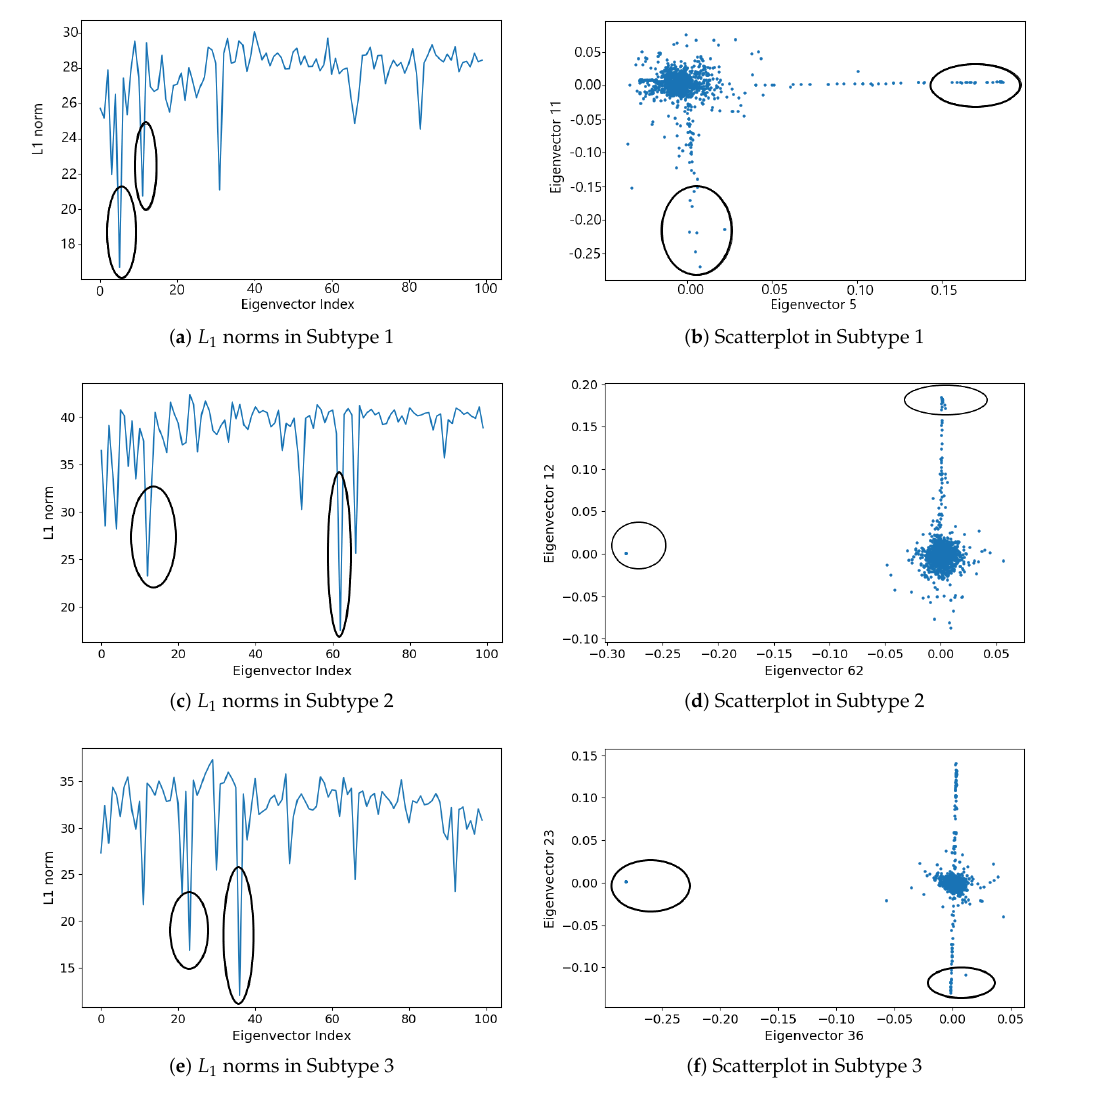
Figure 5. Eigenvector L 1 norms (left column): ( a ) L 1 norms in Subtype 1, ( c ) L 1 norms in Subtype 2, and ( e ) L 1 norms in Subtype 3. Scatterplots of the projection into the subspace defined by the indicated eigenvectors (right column): ( b ) Scatterplot in Subtype 1, ( d ) Scatterplot in Subtype 2, and ( f ) Scatterplot in Subtype